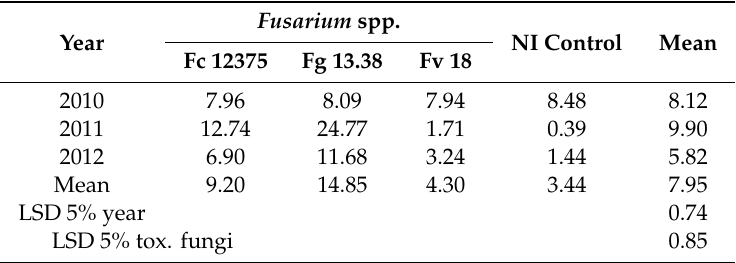
Table 4. Influence of years on the ear rot contamination (%) caused by toxigenic fungi in maize hybrids, toothpick method and natural infection, Szeged, 2010–2012.